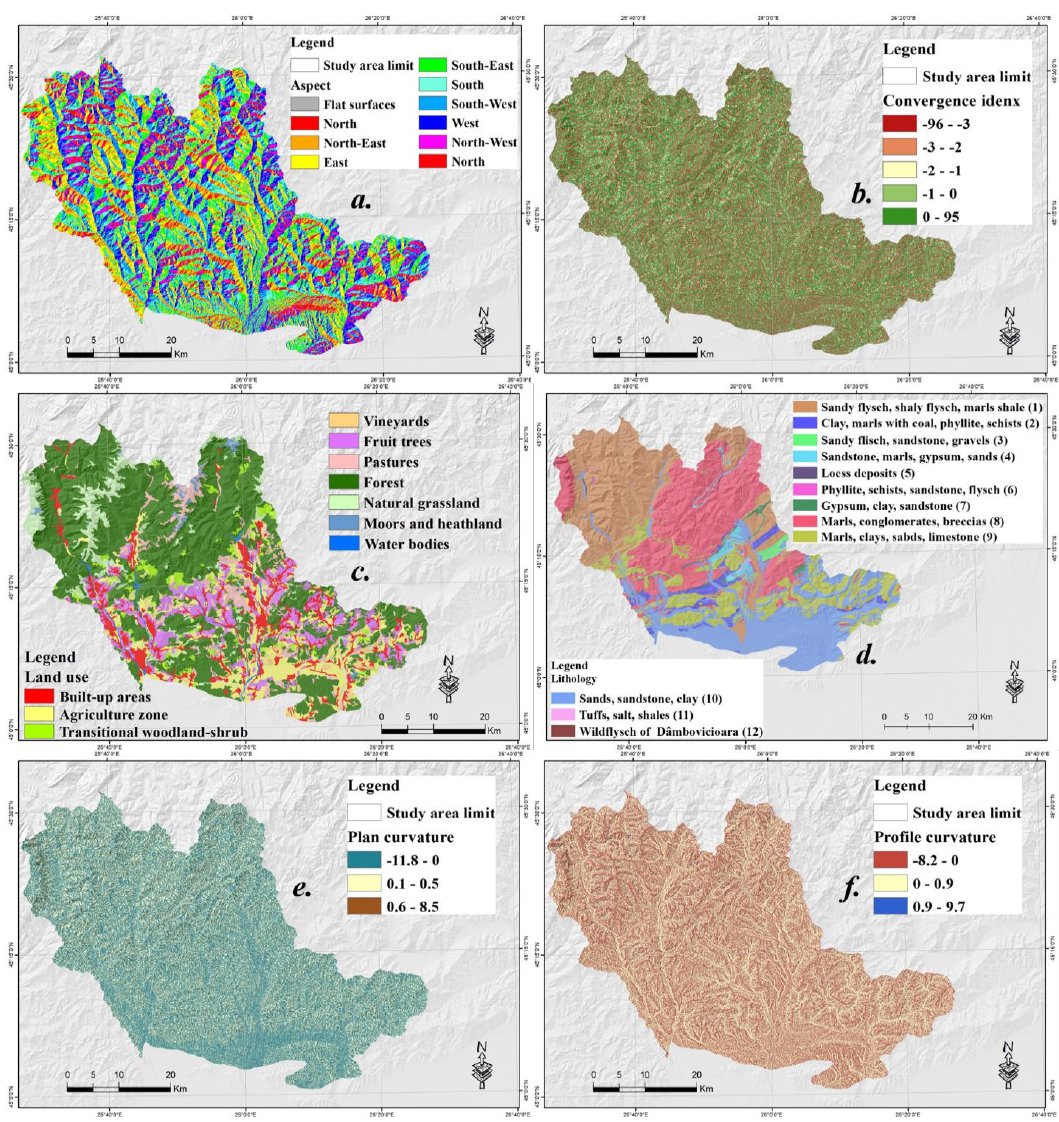
Figure 4. Flash-flood predictiors used in this research: ( a ). aspect; ( b ). convergence index; ( c ). land use; ( d ). lithology; ( e ). plan curvature; ( f ). profi.le curvature.